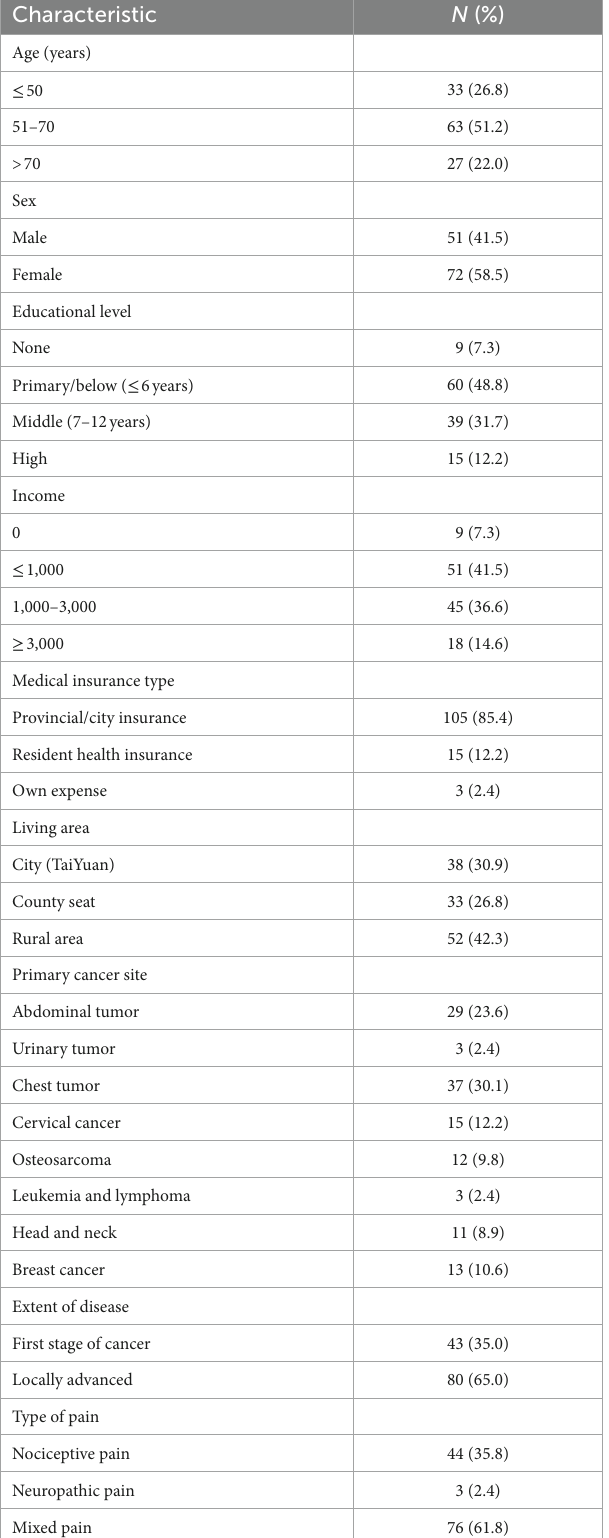
TABLE 1 Description of the study sample ( N =